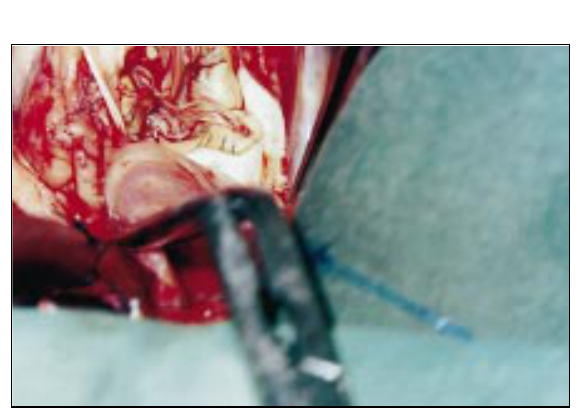
Fig. 3 – Bioprótese aórtica “stentless” implantada. Borda superior da válvula entre os pilares livre de sutura. Fixação dos